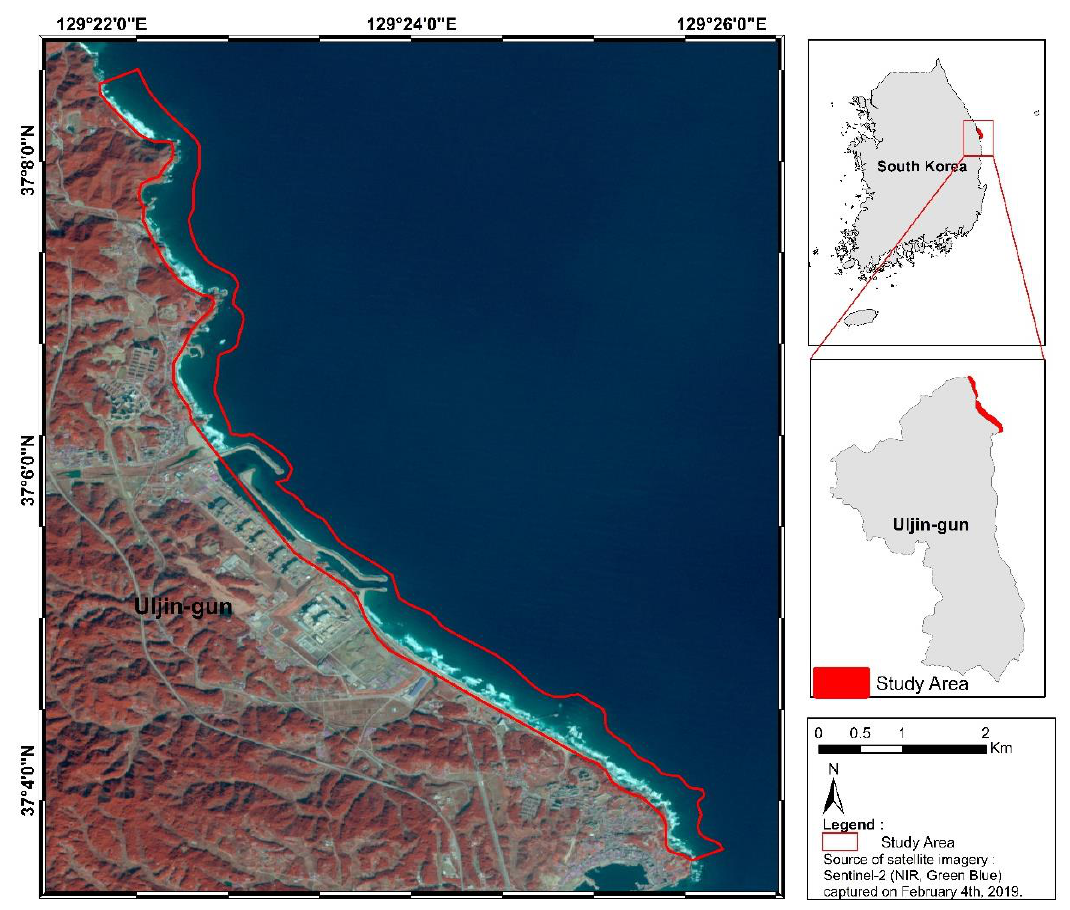
Figure 1 . Area of this study, indicated by a red line